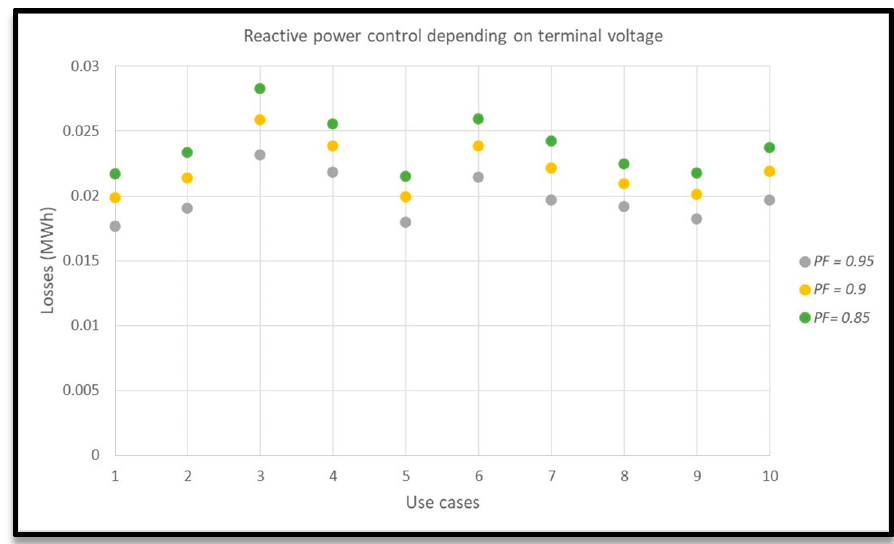
Figure 12. Reactive power control depending on terminal voltage: Losses (More information see Table A9 in Appendix C).